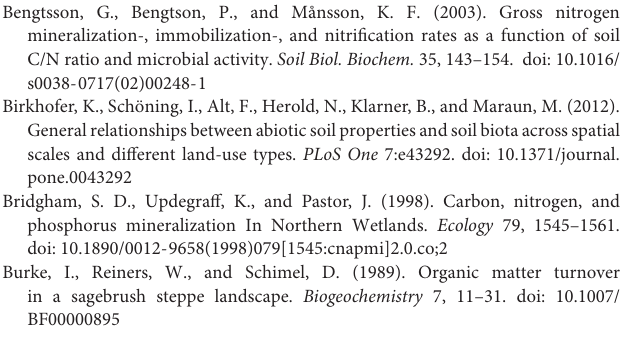
FIGURE S1 | Correlations between CO 2 efflux from samples taken in 2011 and soil organic C from the samples taken in 2014. Study regions are denoted by: ALB, Schwäbische-Alb; HAI, Hainich-Dün; SCH, Schorfheide-Chorin. FIGURE S2 | Comparison of (a) risk (SMIr) and (b) density component (SMId) of the Silvicultural Management Intensity (SMI) index between forest types in different study regions. Error bars represent SE of means. The X -axis represents study regions where ALB, Schwäbische-Alb; HAI, Hainich-Dün; SCH, Schorfheide-Chorin. Significant differences between coniferous and deciduous forests were indicated by ∗ P < 0.05, ∗∗ P < 0.01, and ∗∗∗ P < 0.001. The number of study sites was: ALB (deciduous forests, n = 38 and coniferous forest, n = 12), HAI (deciduous forests, n = 46 and coniferous forest, n = 4), and SCH (deciduous forests, n = 28 and coniferous forest, n =